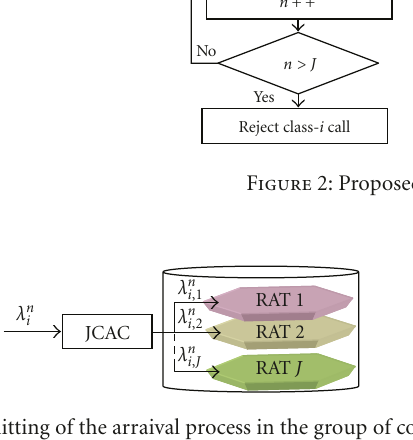
Figure 3: Splitting of the arraival process in the group of colocated